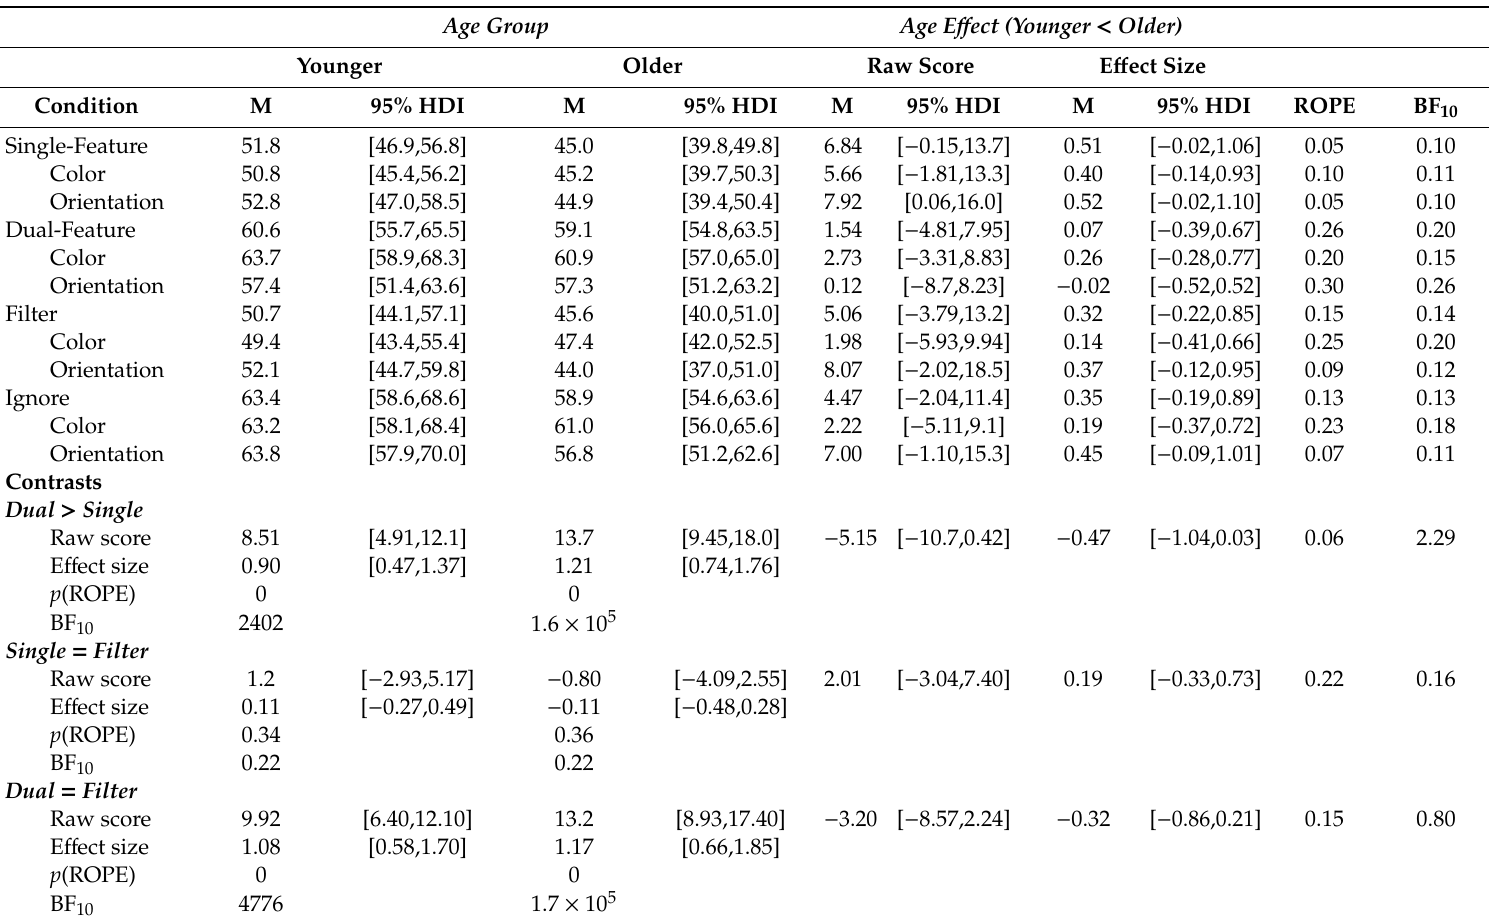
Table 2. Analysis of recall error in Experiment 2. Mean recall error and 95% highest density interval (HDI) estimated from Bayesian t -tests assessing (1) the age e ff ect in each condition, (2) the load (single / dual), filter, and ignore benefit in each age group, and (3) the age e ff ect on the condition e ff